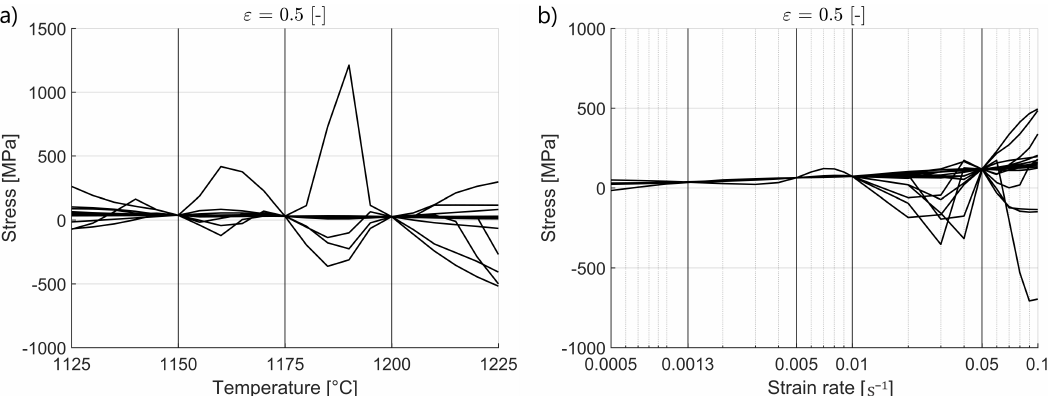
Figure 15. Cross section of interpolated and extrapolated surface plots from 20 tests at 0.5